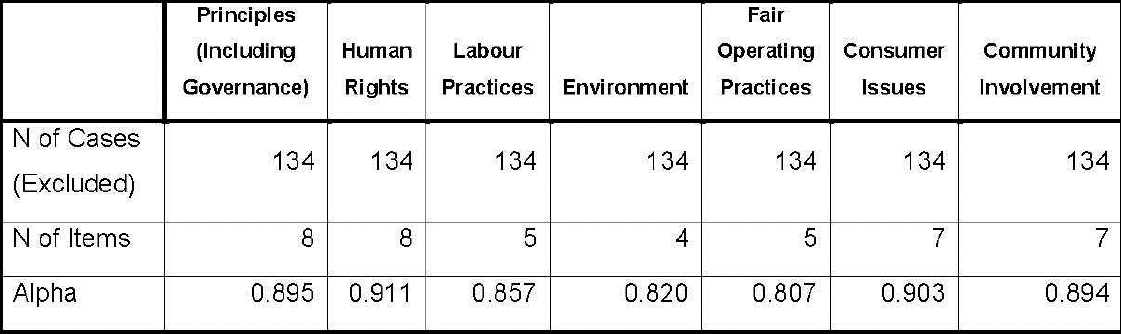
Table 4 Summary of Reliability Scales for 7 Constructs